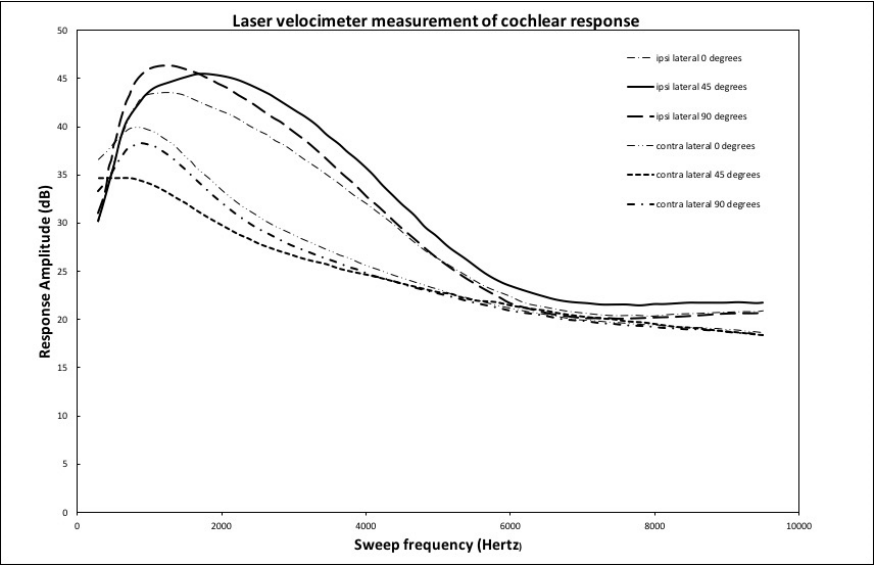
Figure 6. Ipsilateral and contralateral averaged round window response: 0 to 10,000 Hz.